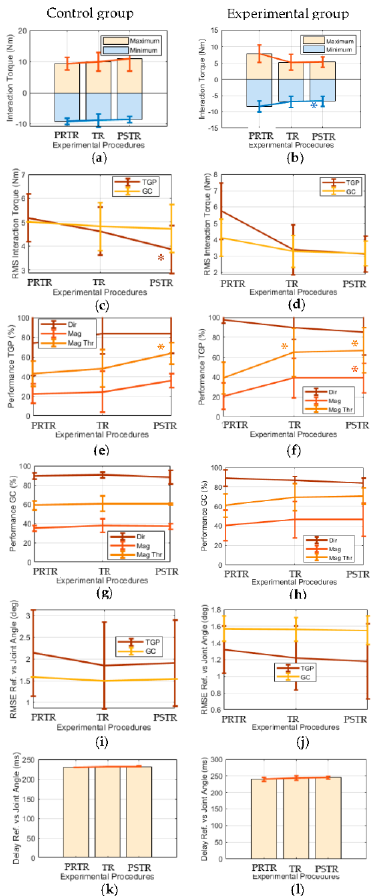
Figure 5. Mean and standard deviation per procedure (PRTR, TR, and PSTR) of ( a , b ) the maximum and minimum human-robot interaction torque; ( c , d ) the RMS of the interaction torque for the training gait phase (TGP) and overall gait cycle (GC); Performance Dir, Mag, Mag Thr for ( e , f ) TGP and ( g , h ) GC; ( i , j ) the RMSE for TGP and GC; and ( k , l ) the delay between the reference joint angle ( Ref ) and real joint angle for the control / experimental group regarding the user participation biofeedback